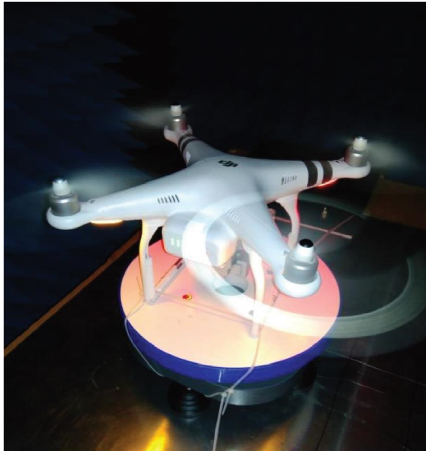
Figure 1: Te DJI Phantom 3 UAS that was primarily used for this